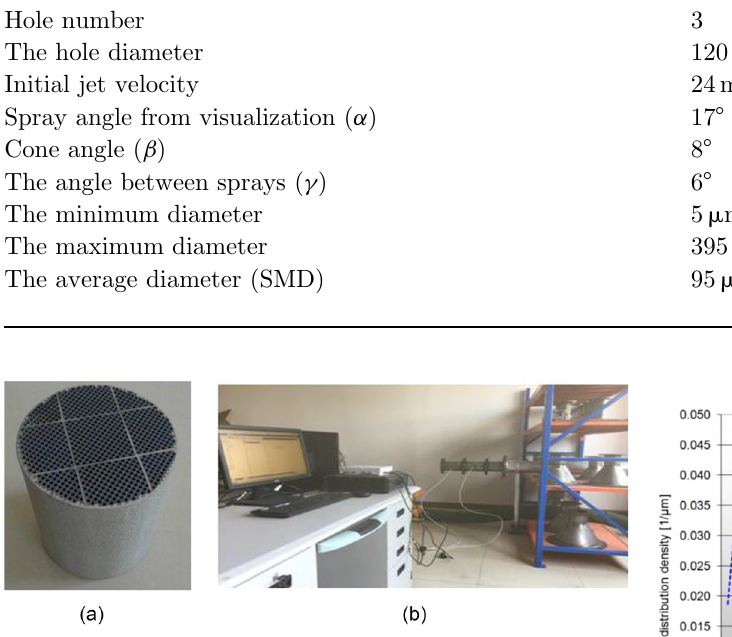
Fig. 4. Backpressure test system. (a) Catalyst carrier. (b) Back- pressure testbench.